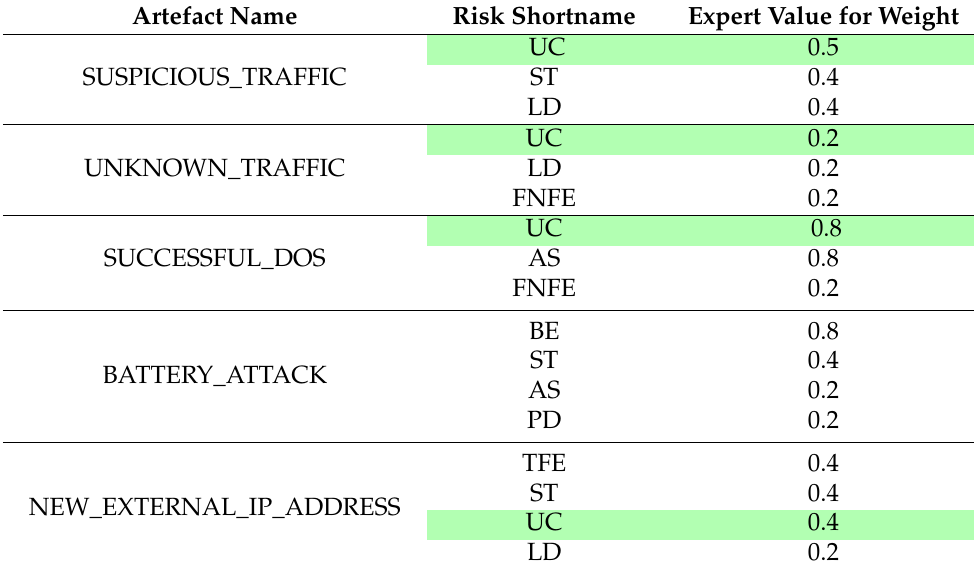
Table 2. Snippet of expert values for